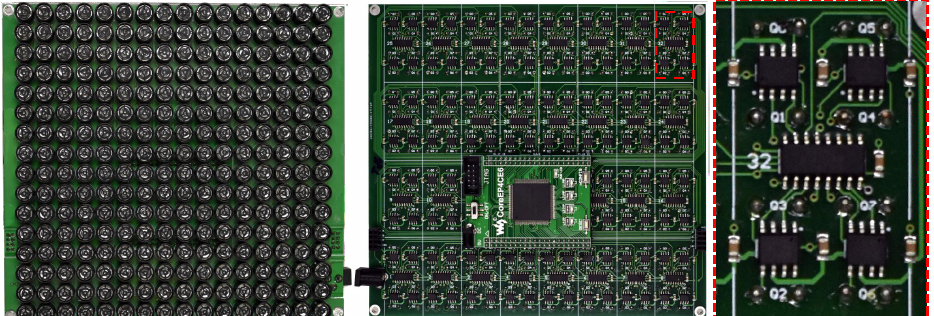
Figure 3. Board with surface mounted devices and emitters of 10 mm diameter. ( left ) Top view of the Sonic surface where 16 × 16 ultrasonic emitters can be seen. At the sides there are connectors for power, Universal asynchronous receiver-transmitter (UART) in, grounds, sync out and sync in. ( center ) bottom view where the shift register blocks can be seen with the FPGA on top. ( right ) closer view on a shift register block where a shift register demultiplexes a digital line into eight signals that are fed to four dual-drivers and then into eight ultrasonic emitters.